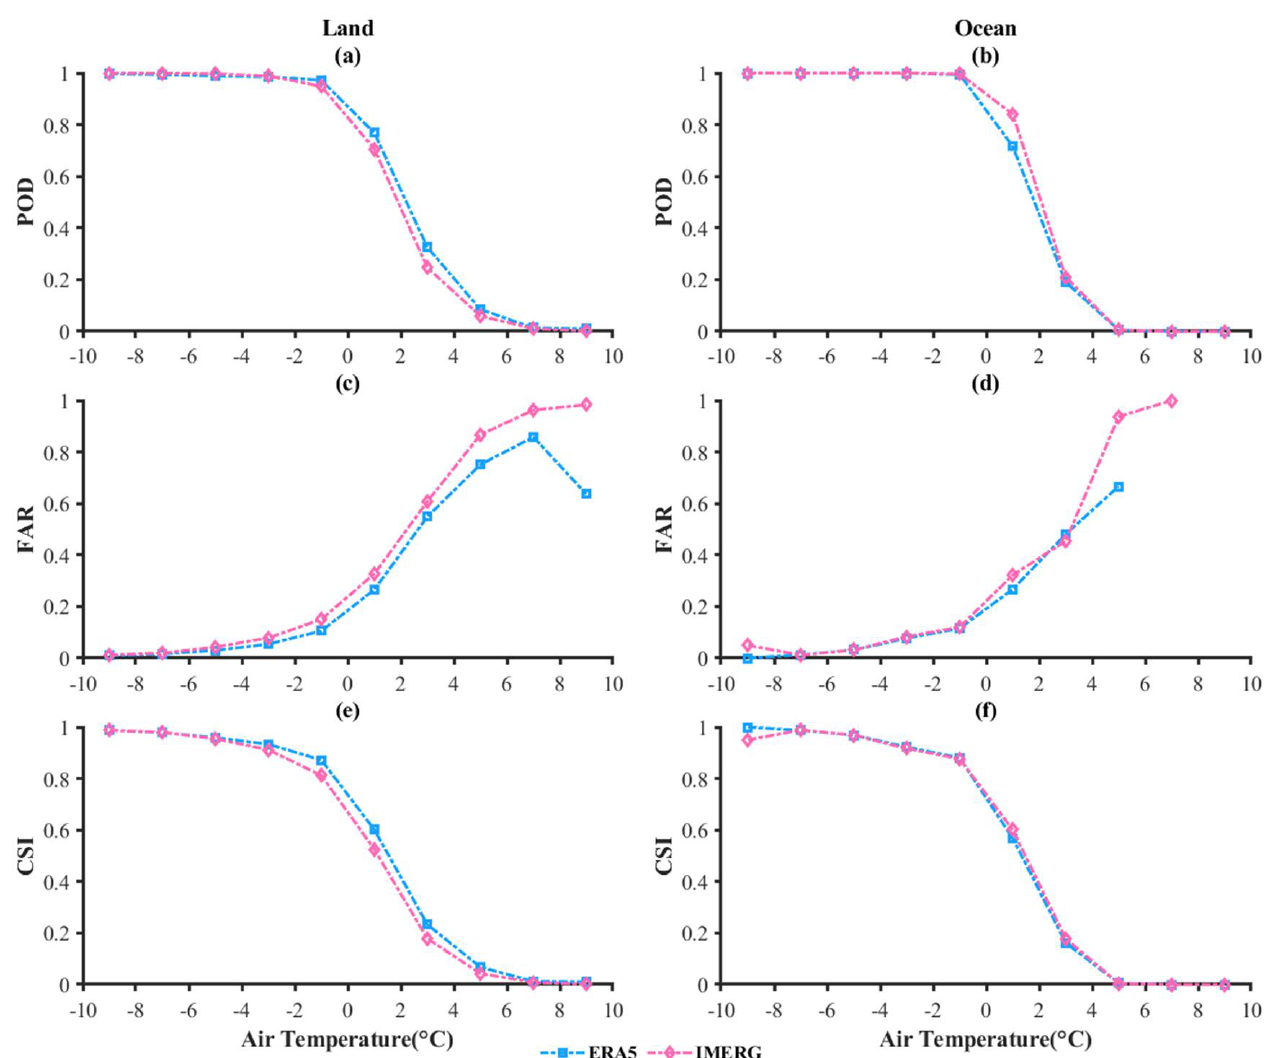
Figure 9. The POD, FAR, and CSI metrics for ERA5 and IMERG products at different air temperatures over global land and ocean. The subplots ( a , c , e ) refer to land, and the subplots ( b , d , f ) refer to ocean. Figure 10 shows the snowfall events, rainfall events, and mean air temperature of IMERG and ERA5 products with different precipitation intensities on the global scale. The snowfall and rainfall events of IMERG and ERA5 both gradually decreased while the mean air temperature rose. ERA5 showed more non-precipitation events than IMERG, somehow indicating that the IMERG products can detect more light precipitation events. As shown in Figure 10, the IMERG and ERA5 products have similar snowfall event ratios. However, the mean temperature of ERA5 is obviously lower than IMERG precipitation intensity between 0.1–0.5 mm/h. The possible reasons for this phenomenon are: (1) the IMERG products overestimate the air temperature for light precipitation; (2) the missing lower temperature records of IMERG for light